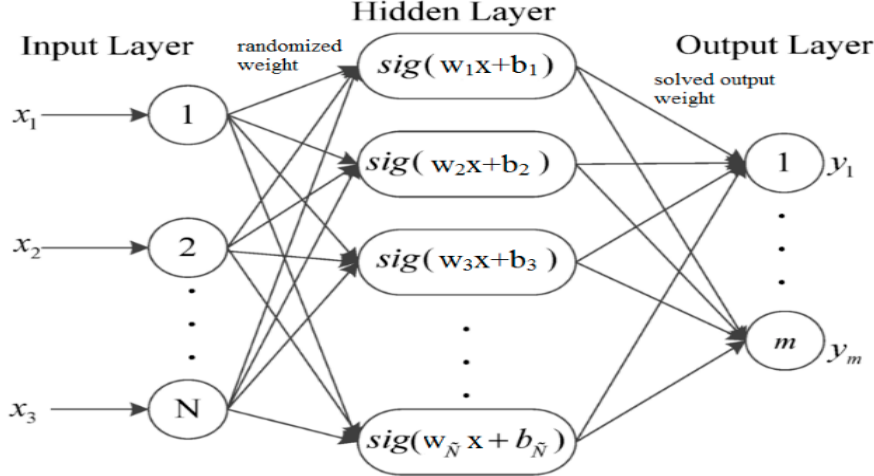
Figure 8. ELM architecture.